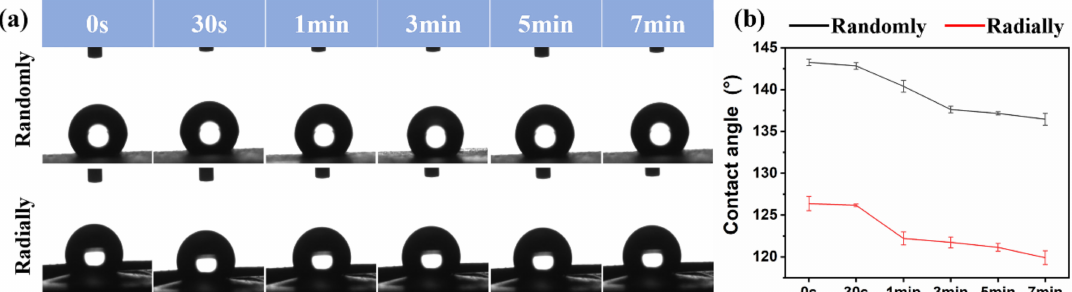
Figure 7. Water contact angles of as-prepared PHBV nanofiber scaffolds with both randomly and radially oriented patterns: ( a ) actual photographs; ( b ) statistical